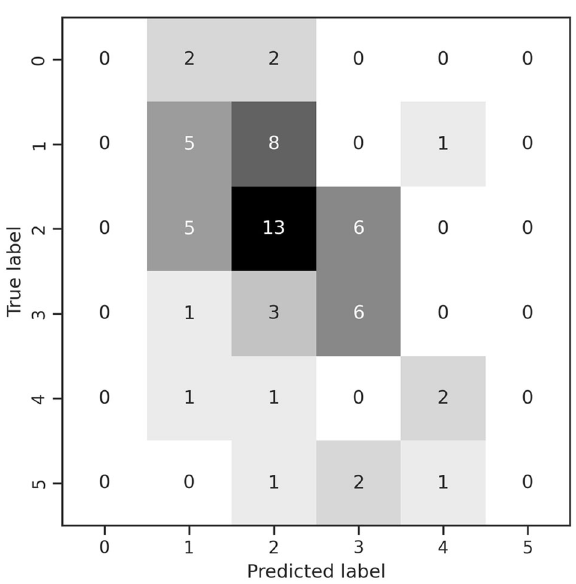
Fig. 1 Results from SARA prediction. Confusion matrix of true and predicted SARA-scores based on SARA speech machine learning approach using a broad set of voice